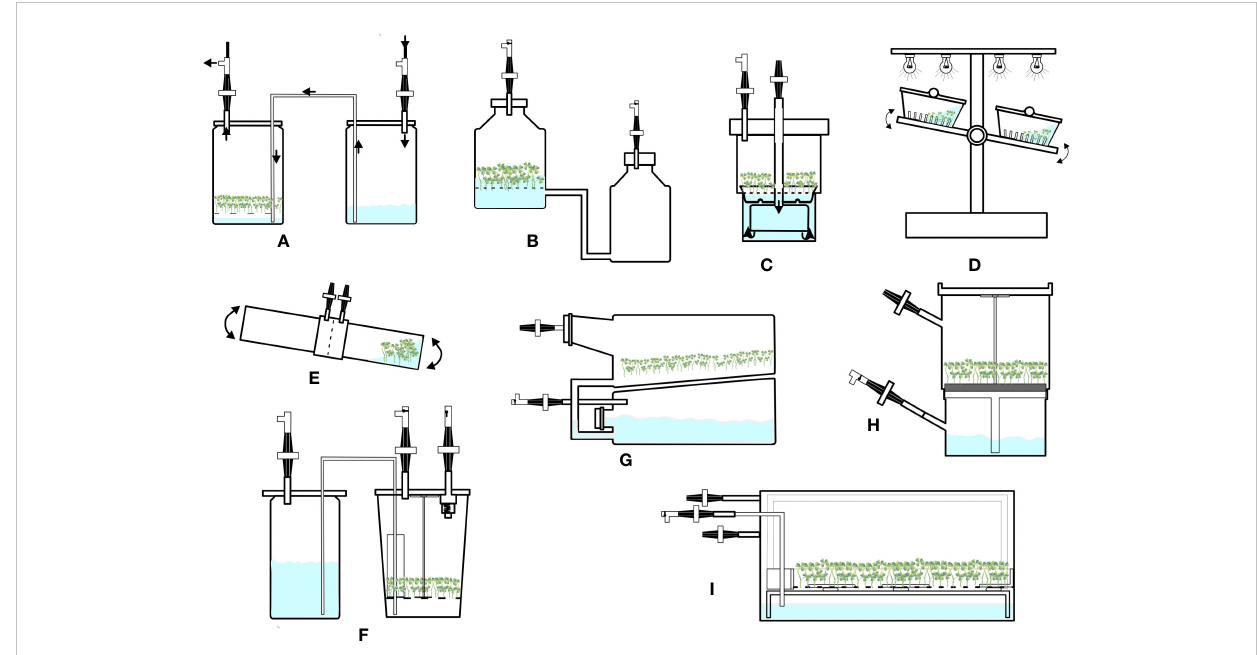
FIGURE 3 Con fi gurations of temporary immersion bioreactors. (A) Twin fl ask bioreactor. (B) Ebb and fl ow bioreactor. (C) RITA bioreactor. (D) Rocker system. (E) Bio-MINT bioreactor. (F) RALM bioreactor. (G) SETIS bioreactor. (H) PLANTIMA system. (I) PLANTFORM